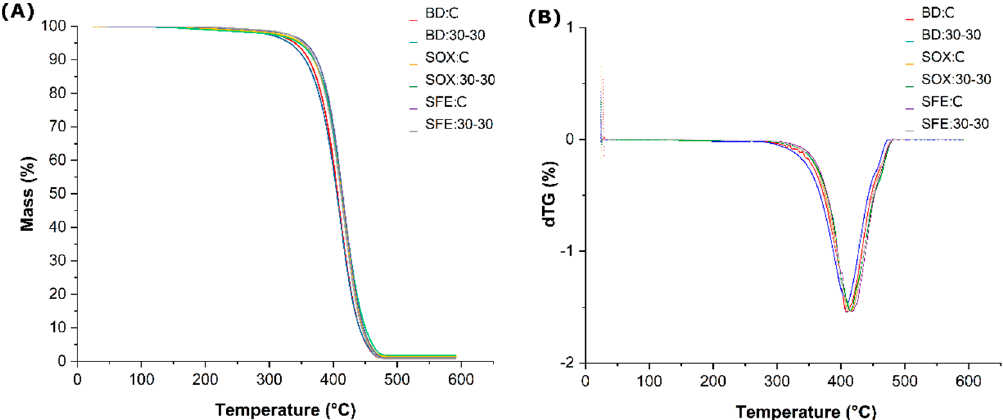
Figure 9. ( A ) Thermogravimetric curve (TGA) ( B ) derivative thermogravimetry (DTG) curves of grape seed oils for supercritical (SFE), Soxhlet (Sox) and Bligh Dyer (BD) extractions from the untreated (Control) and pretreated sample. treatment (30-30).